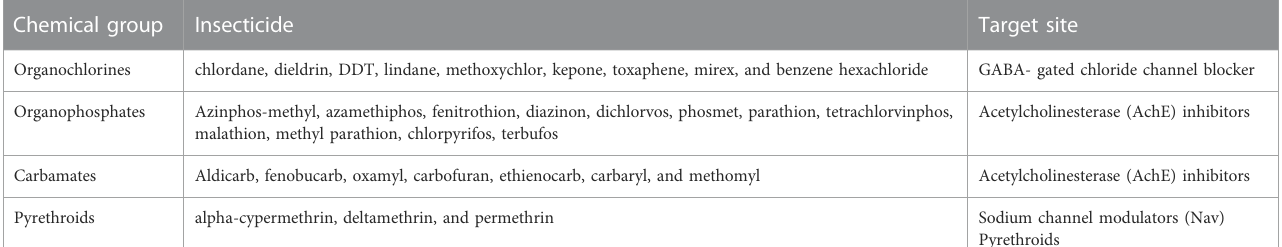
TABLE 3 Insecticide classi fi cation based on target